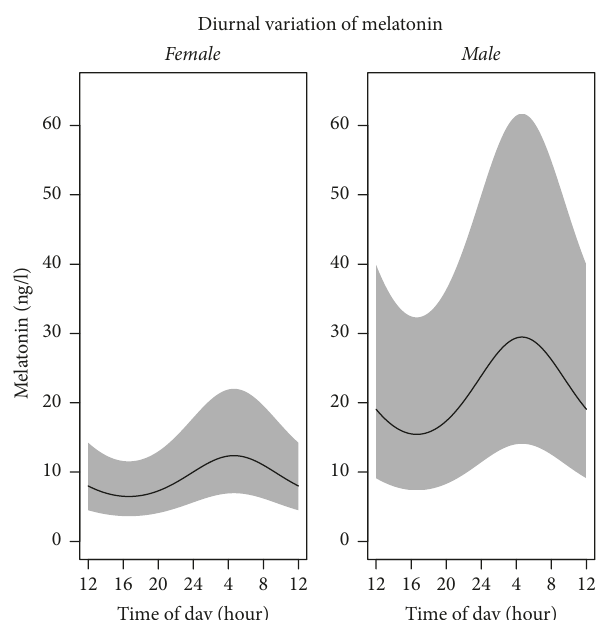
Figure1:Diurnalvariationofmelatoninbygender.Meanmelatonin values, ng/L; the grey field represents confidence